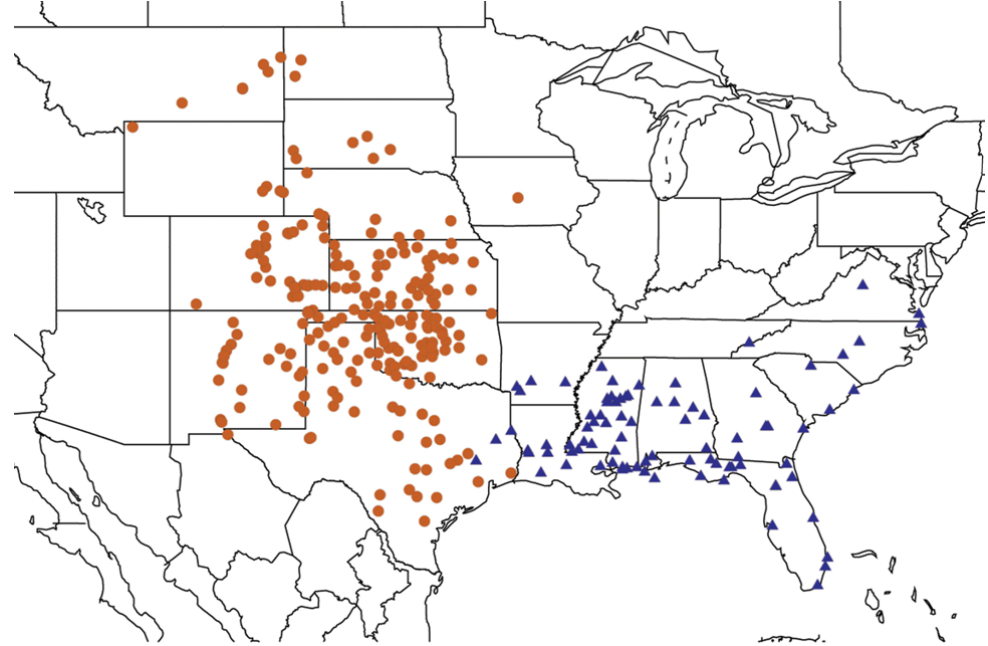
Figure 22. Distribution of Tibicen dealbatus (orange circles) and T. figuratus (blue triangles).